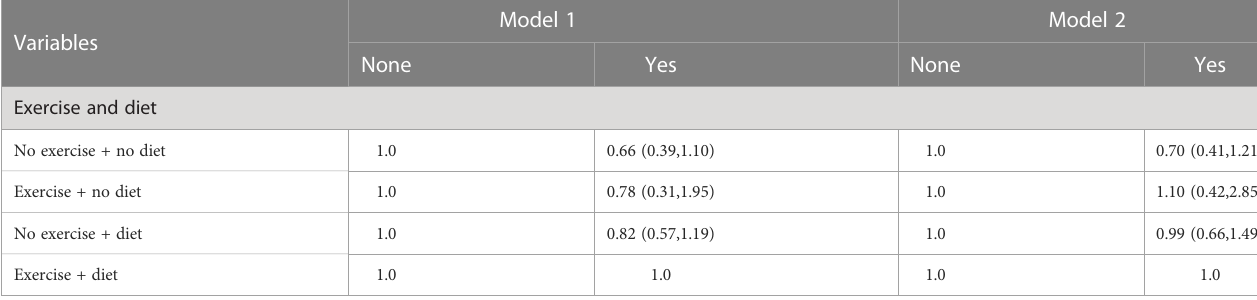
TABLE 16 The correlation between intervene and CVD (male).